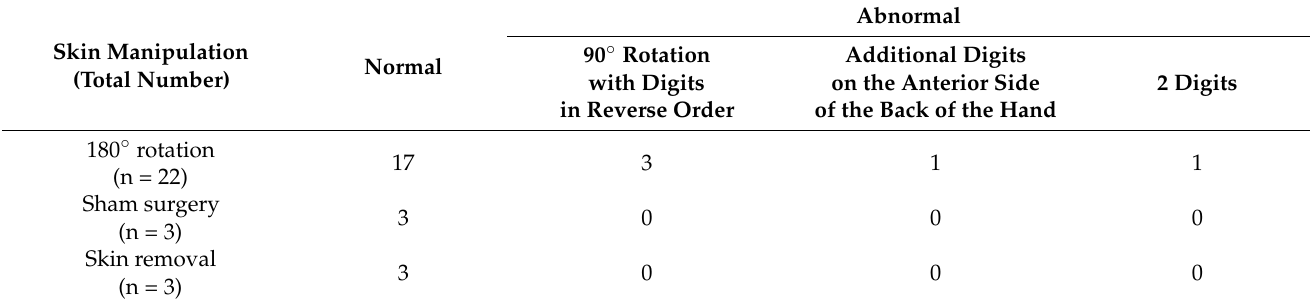
Table 1. Effects of 180 ◦ skin rotation on the axial pattern of the regenerating